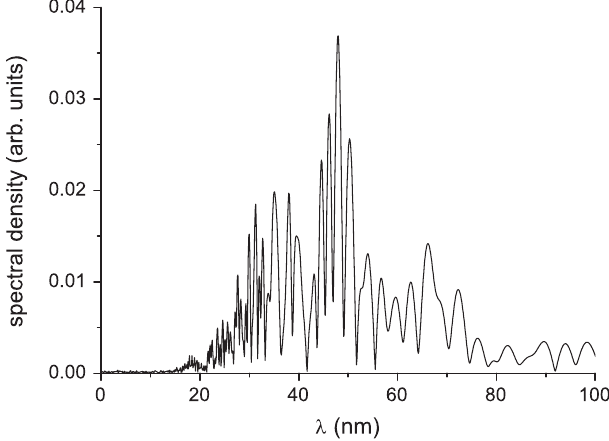
FIG. 5. Spectrum of the modulated electron current (modulus of the bunch form factor) after the third amplification cascade. The calculations were performed with ASTRA